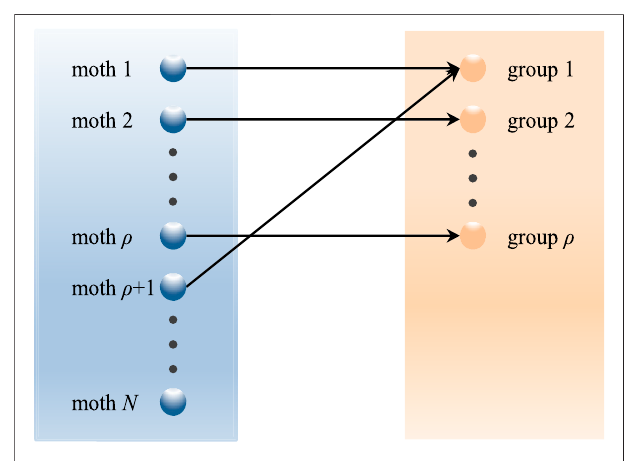
FIGURE 3 | Diagram of grouping